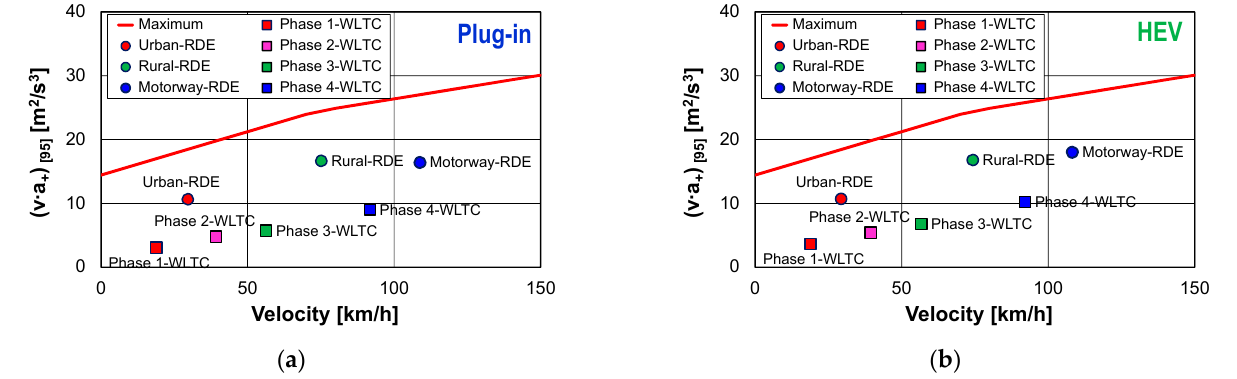
Figure 29. Comparison of the 95th percentile multiplication of velocity and acceleration from the RDE and WLTC tests for: ( a ) plug-in; ( b ) HEV.